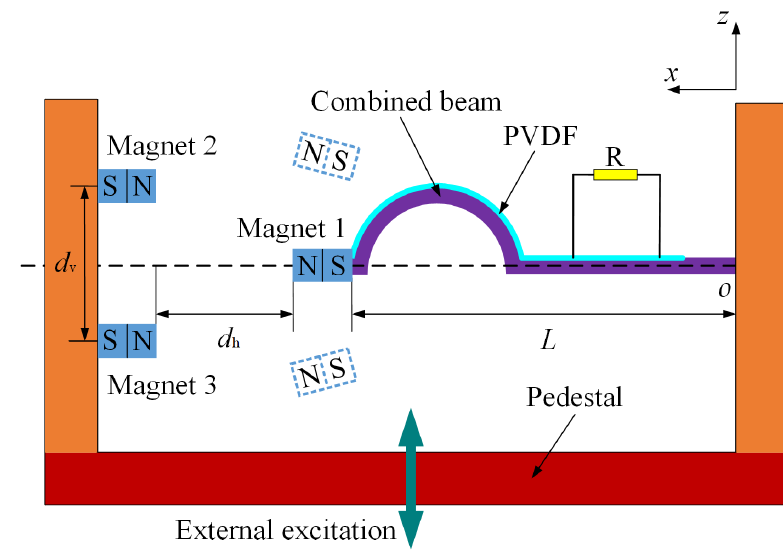
Figure 1. Overall schematic diagram of CTEHS.